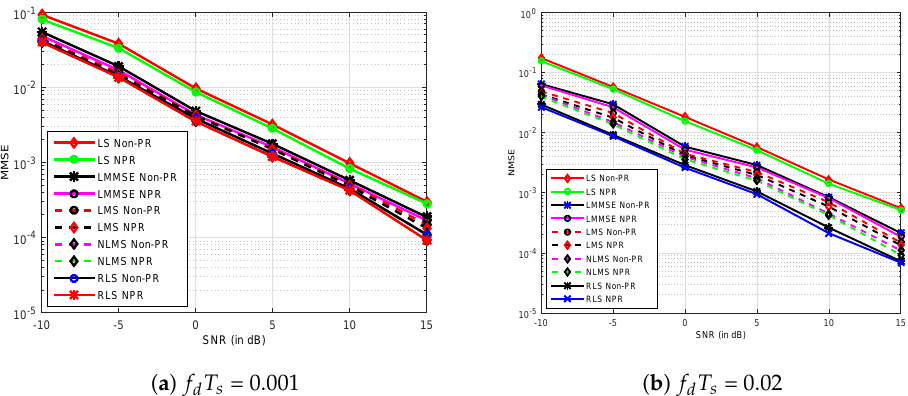
Figure 23. Estimators performance comparison in terms of NMSE versus SNR.